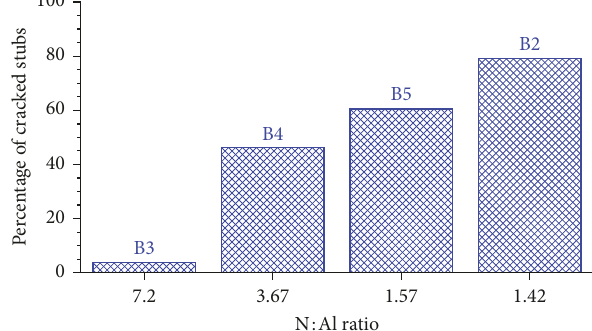
Figure 11: Analysis of the N : Al ratio for specific casts of Grade 91 steel as a function of the percentage of stubs cracked in a give barrel section. Adapted from